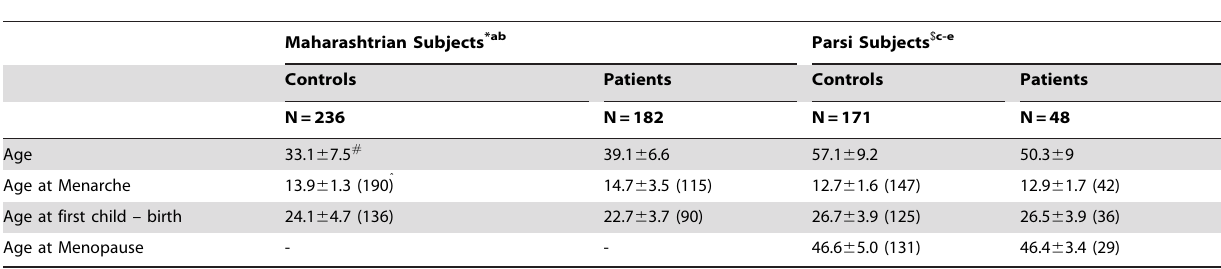
Table 1. Reproductive health history of the study